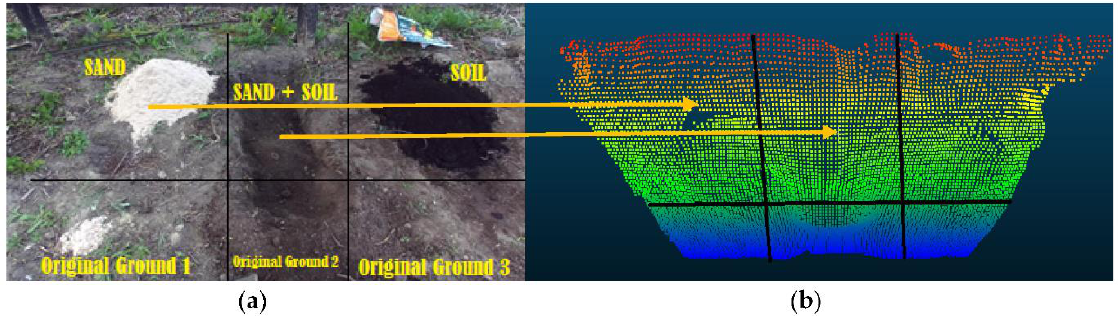
Figure 10. ( a ) Excavation ground segments considered for experiments; ( b ) Point clouds obtained from a stereo vision camera in each segment.